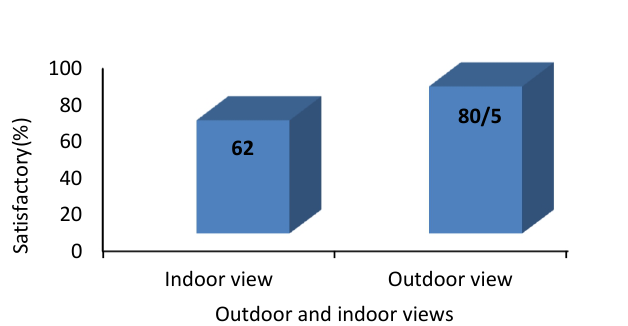
Fig. 3. The mean of satisfaction score based on outdoor and indoor views